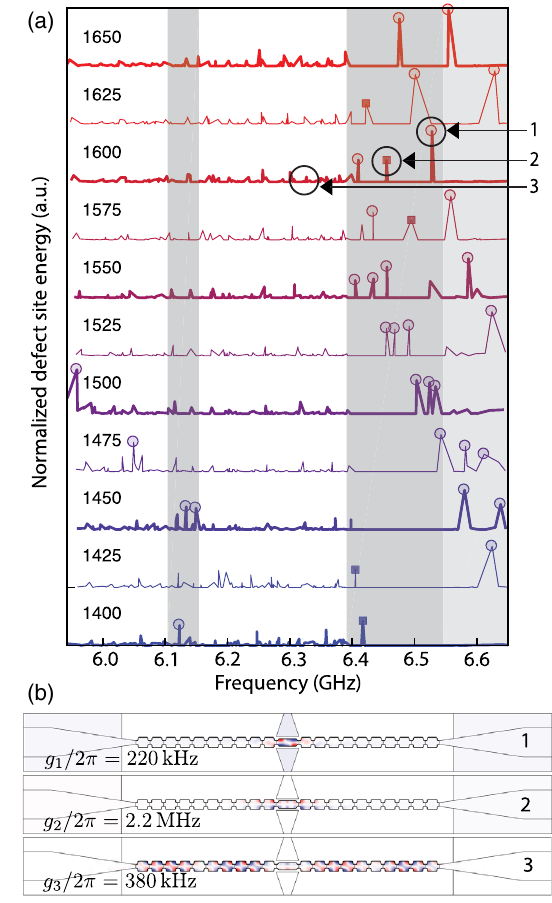
FIG. 7. Simulated mechanical spectra. (a) Eigenfrequency 1400 ; simulation results for cavities with defect lengths a def ¼ f 1425 ; … ; 1650 g nm. The normalized defect-site energies (which are unitless and range from 0 to 1) are plotted for all the modes in the frequency range 6 – 6.6 GHz, with the bold lines correspond- ing to the fabricated defect lengths. The mirror cell design is the same as that used for the band diagram of Fig. 1(a); here, the positions of the complete and partial phononic band gaps are indicated with dark grey and light grey regions. Modes with defect energy greater than 0.3 are considered “ localized ” and are marked with a circle, and localized modes with the correct polarization are marked with a filled square. We see that as the defect length is increased, several modes shift into the band gap and become localized, but only a small fraction of them have the correct polarization. (b) Electrostatic potential of the three modes labeled in (a), which have distinct profiles and coupling rates. Only modes that have the right polarization and are localized have simulated coupling rates that exceed 1